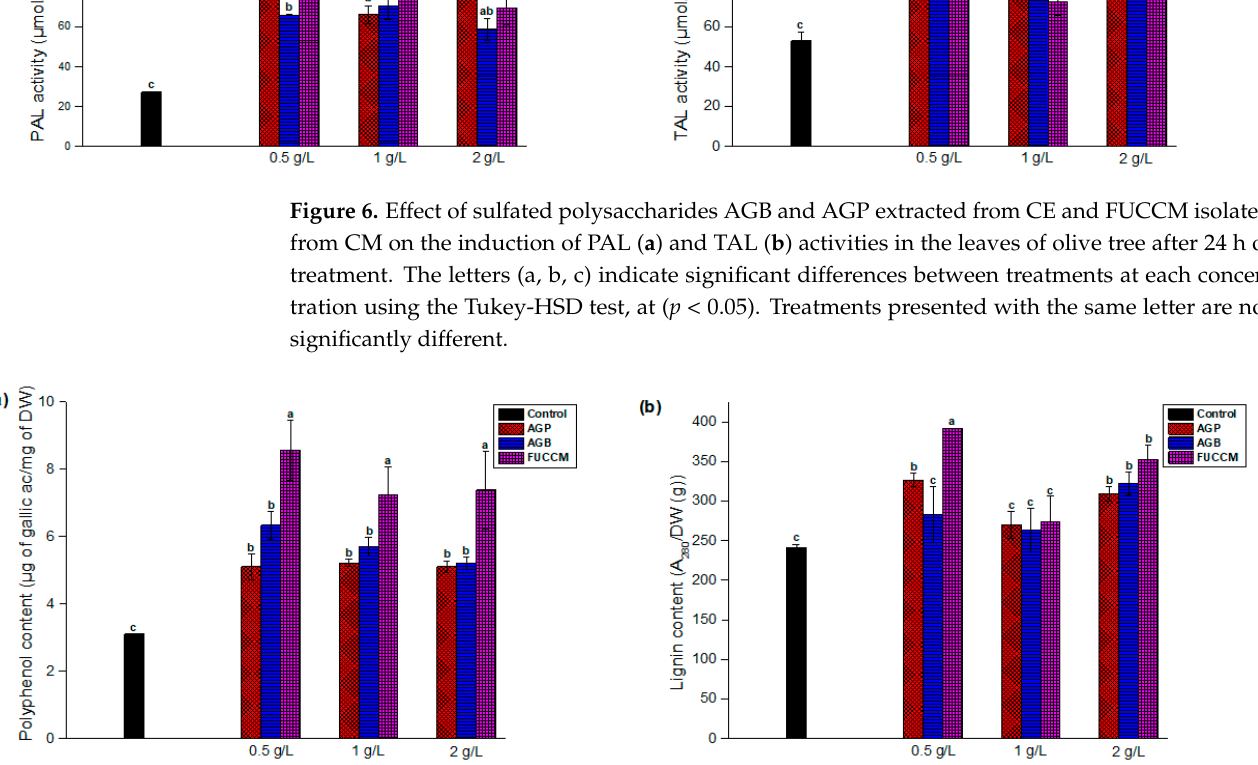
Figure 7 . Effect of sulfated polysaccharides AGB and AGP extracted from CE and FUCCM isolated from CM on the induction of polyphenol ( a ) and lignin ( b ) contents in the leaves of olive tree after 24 h of treatment. The letters (a, b, c) indicate significant differences between treatments at each concentration using the Tukey-HSD test, at ( p < 0.05). Treatments presented with the same letter are not significantly different.